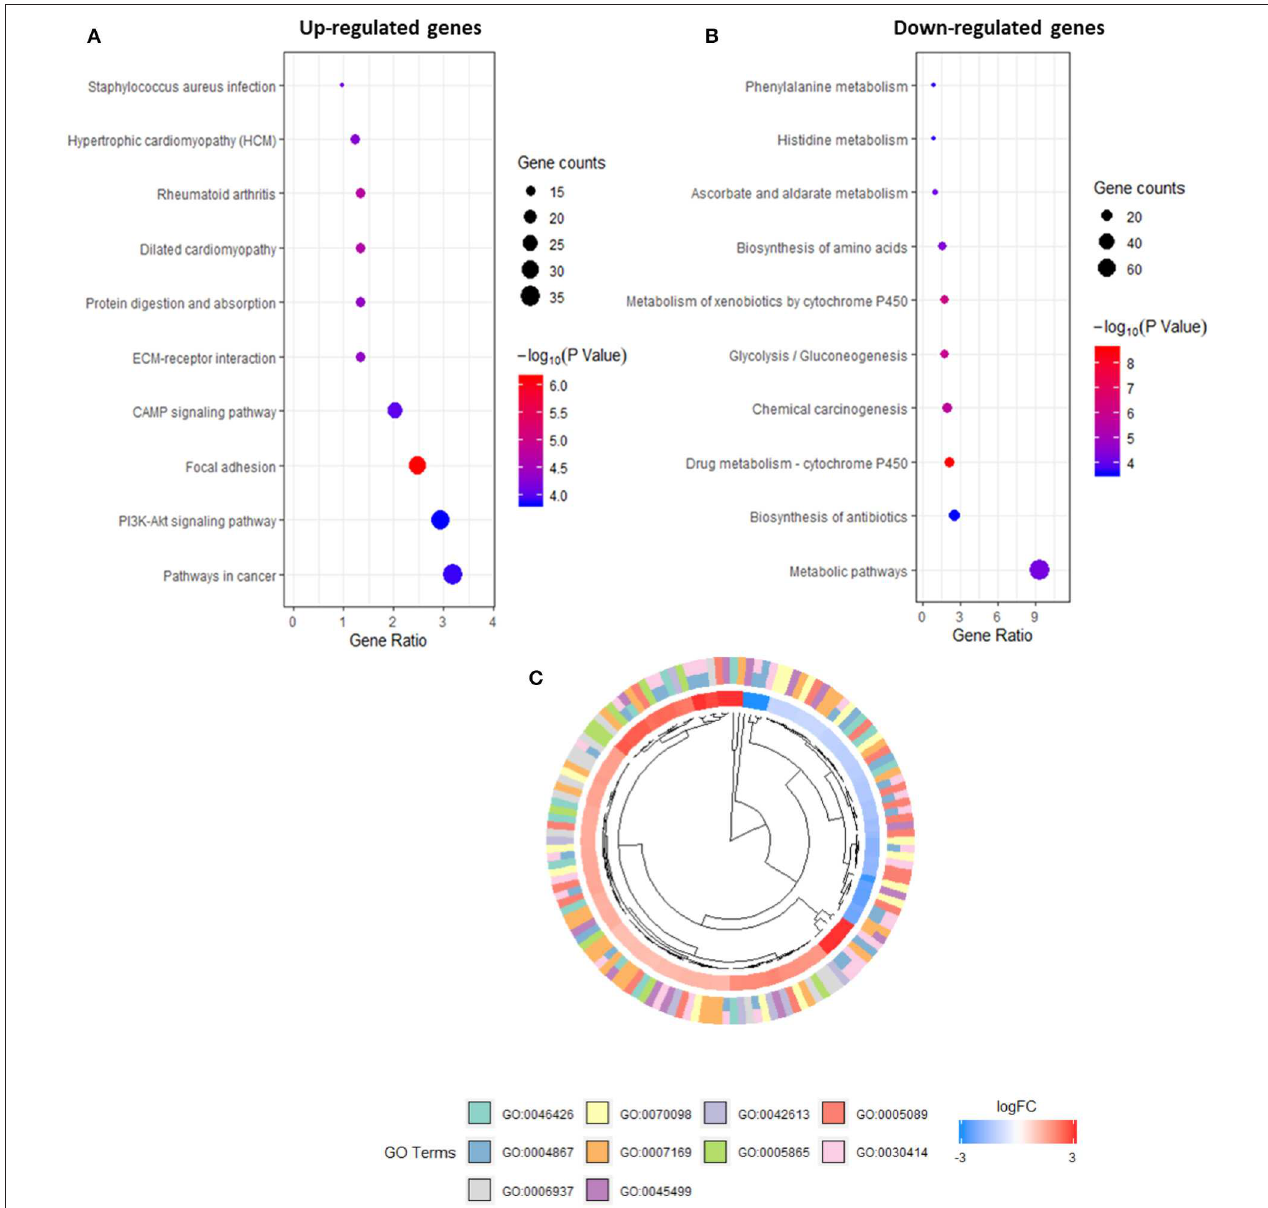
FIGURE 3 | Kyoto Encyclopedia of Genes and Genomes (KEGG) pathway analysis of promoters in up-regulated (A) and down-regulated expression (B) . Gene Ontology (GO) terms within differentially expressed promoters [false discovery rate (FDR) > 0.05] in intraductal papillary mucinous neoplasm (IPMN) (C)